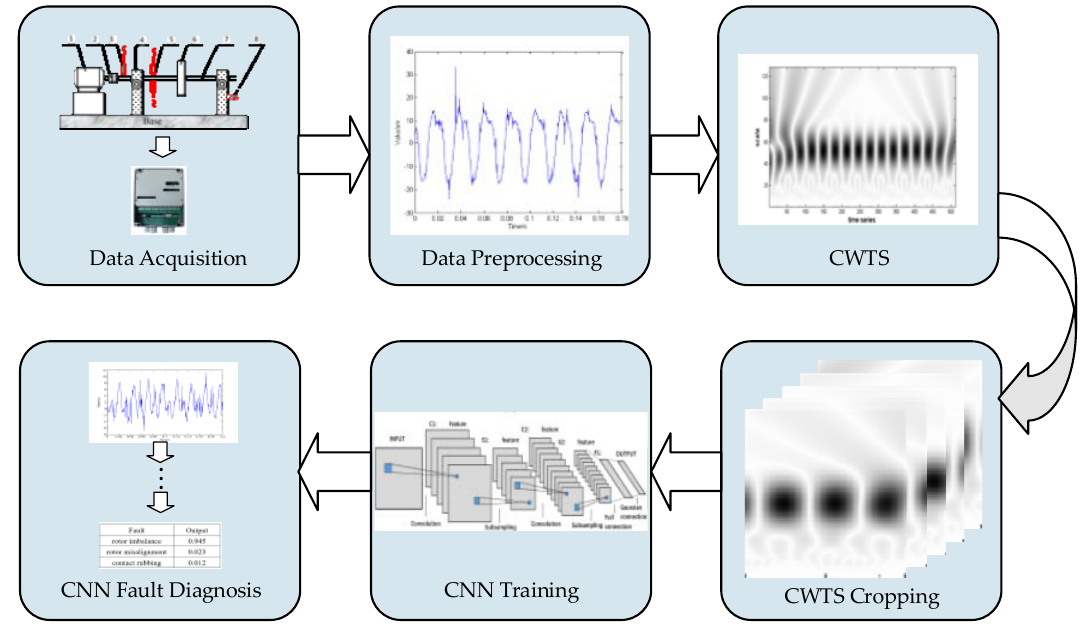
Figure 1. Flow chart of proposed fault diagnosis method.